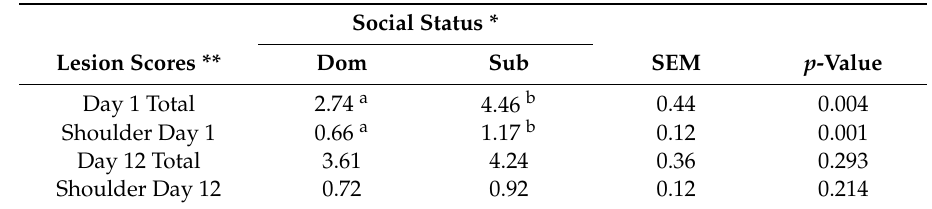
Table 6. E ff ects of social status on skin lesion scores in focal sows. Sows measured on treatment days 1 and 12.